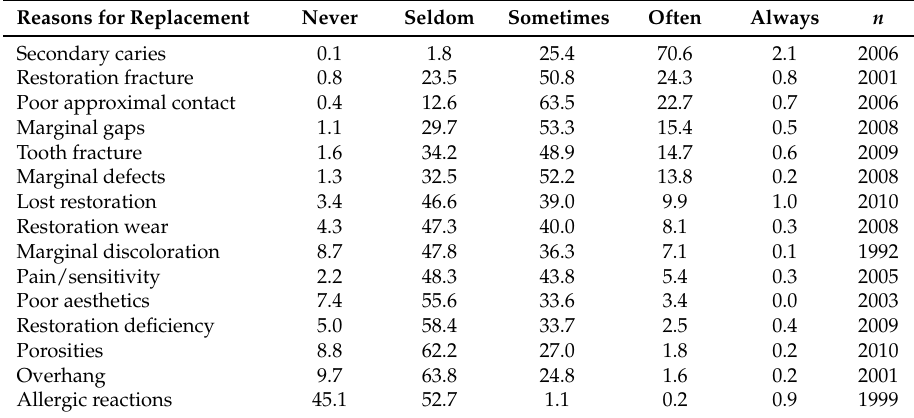
Table 2. What is in your opinion the cause when Class II composite restorations in permanent premolars and molars need replacement (%)?